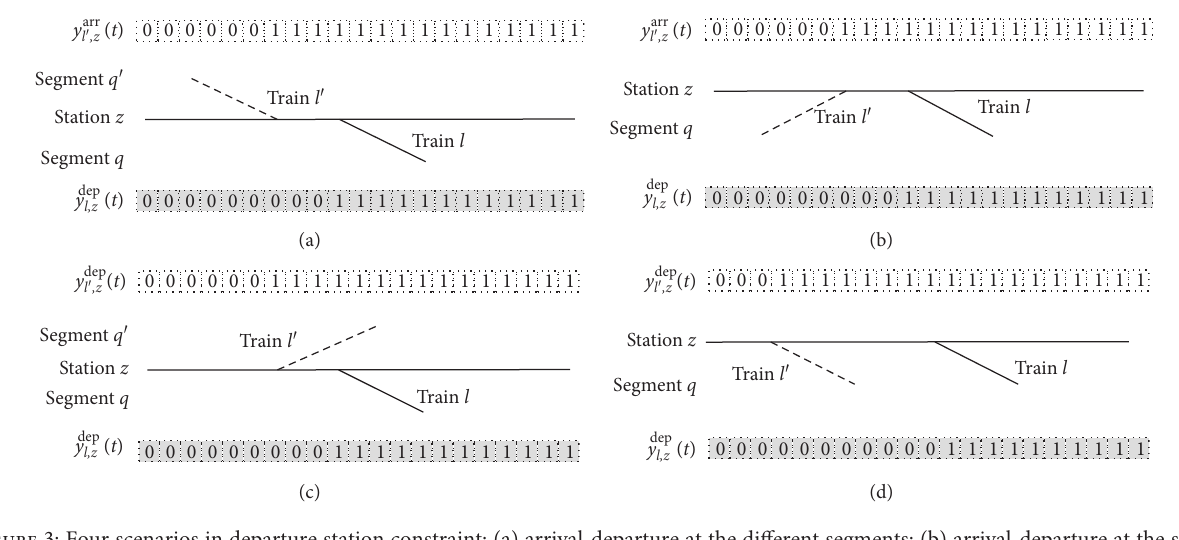
Figure 3: Four scenarios in departure station constraint: (a) arrival-departure at the different segments; (b) arrival-departure at the same segment; (c) departure-departure at the different segments; (d) departure-departure at the same segment.